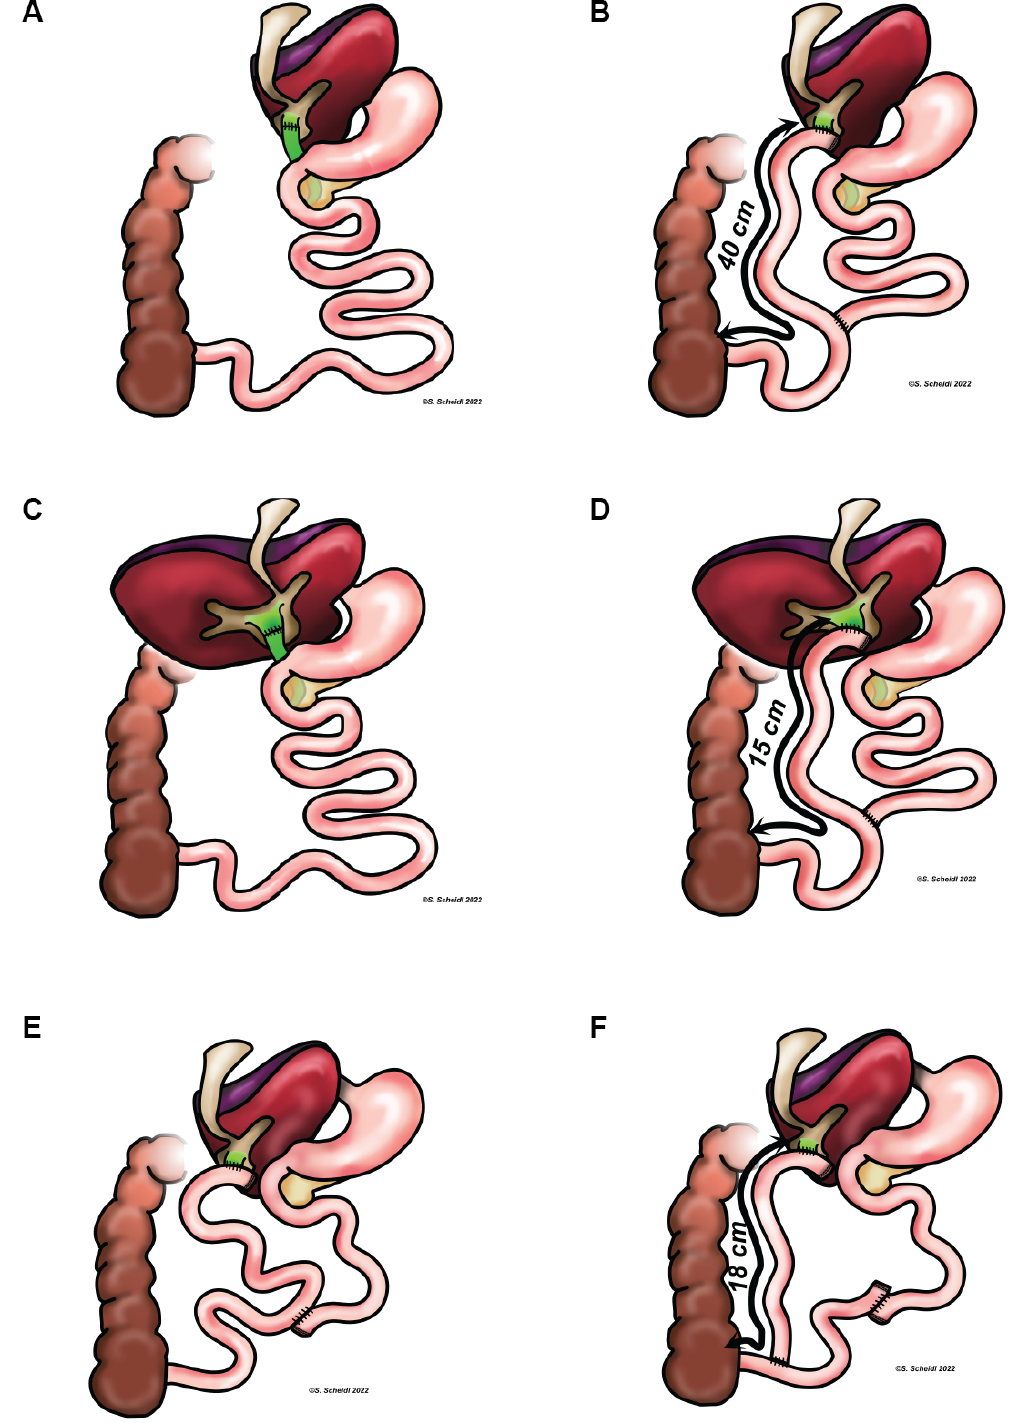
Figure 1. Biliary reconstruction after liver transplantation ( A , C , E ) and corresponding anatomy after internal biliary diversion ( B , D , F ). Anatomical situation after liver transplantation and before ( A ) as well as after ( B ) biliary diversion in case 1, case 2 ( C , D ), and case 3 ( E , F ), respectively.